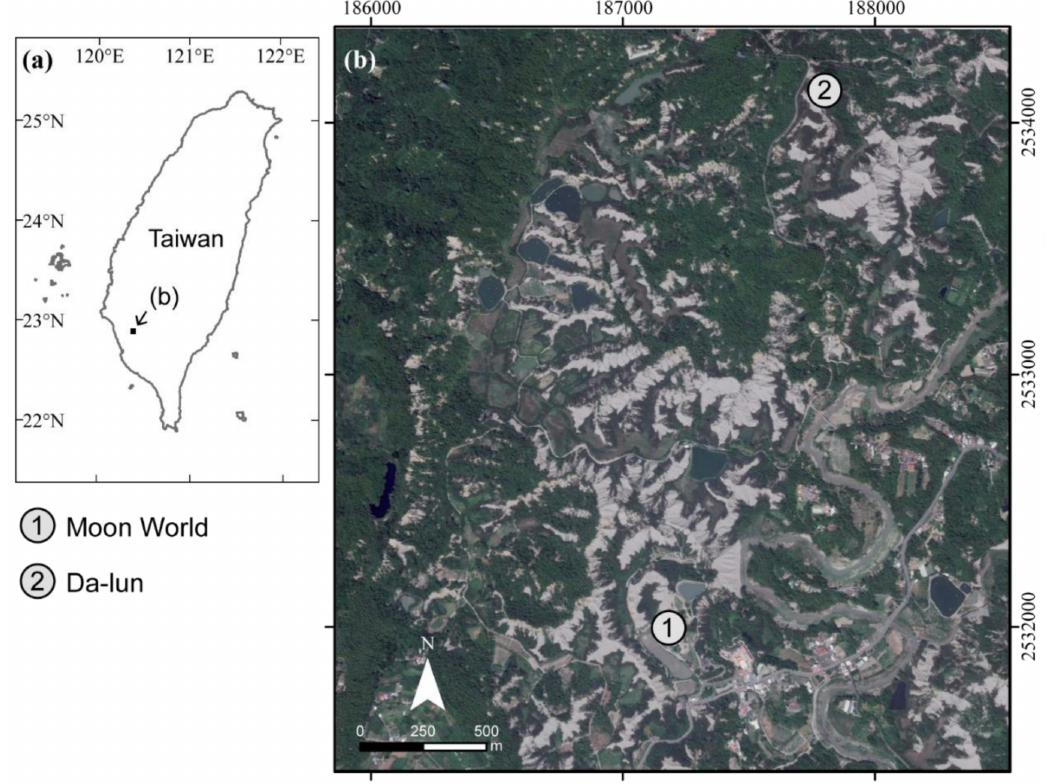
Figure 1. Location of the study area in southern Taiwan (image source: Google